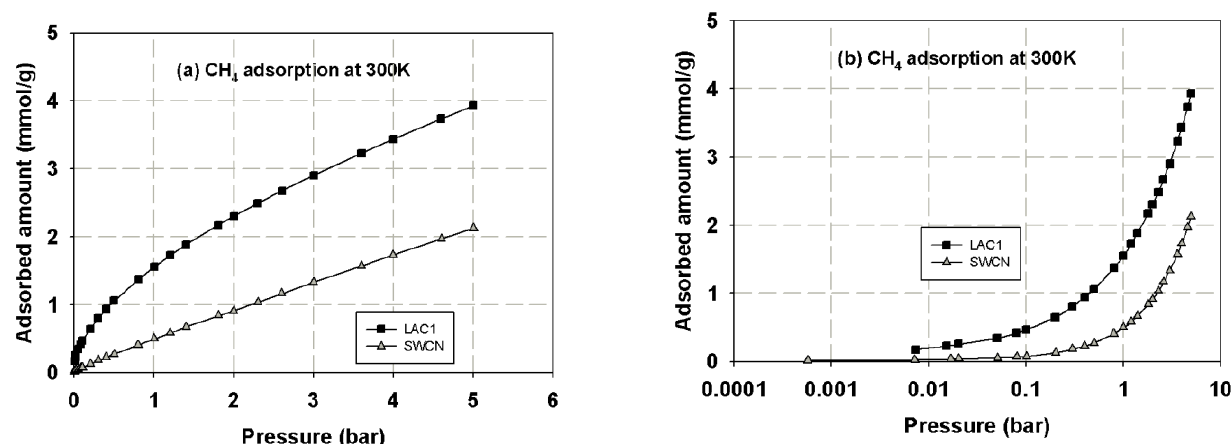
Figure 3. Adsorption isotherms of methane in activated carbons and single wall carbon nanotube at 273 K in linear ( a ) and semi-log ( b ) scales.